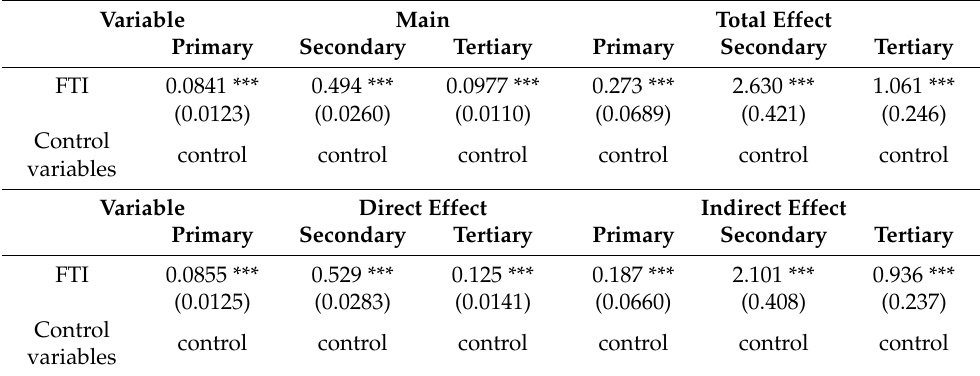
Table 7. Regression results of spatial Durbin model for primary, secondary and tertiary forestry